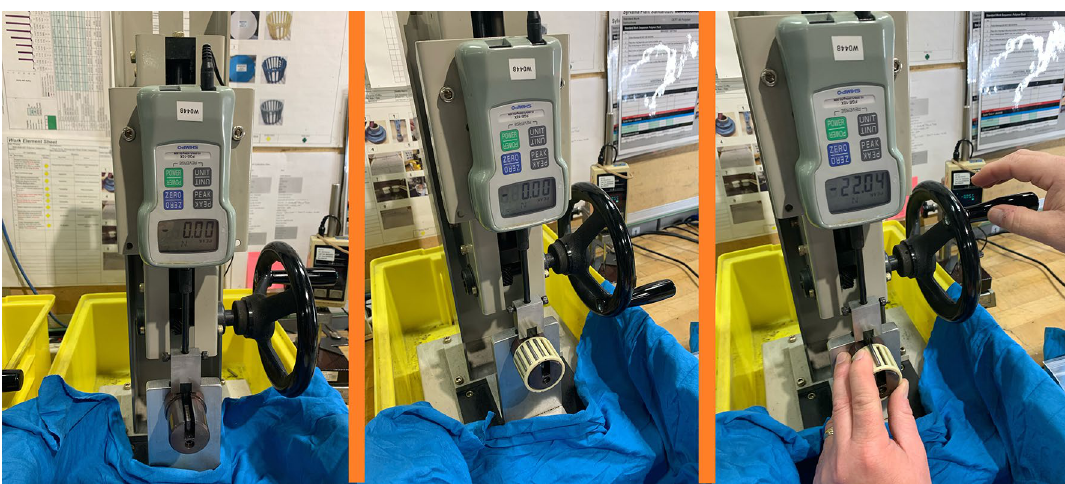
Figure 5. Experimental setup of the push-out force